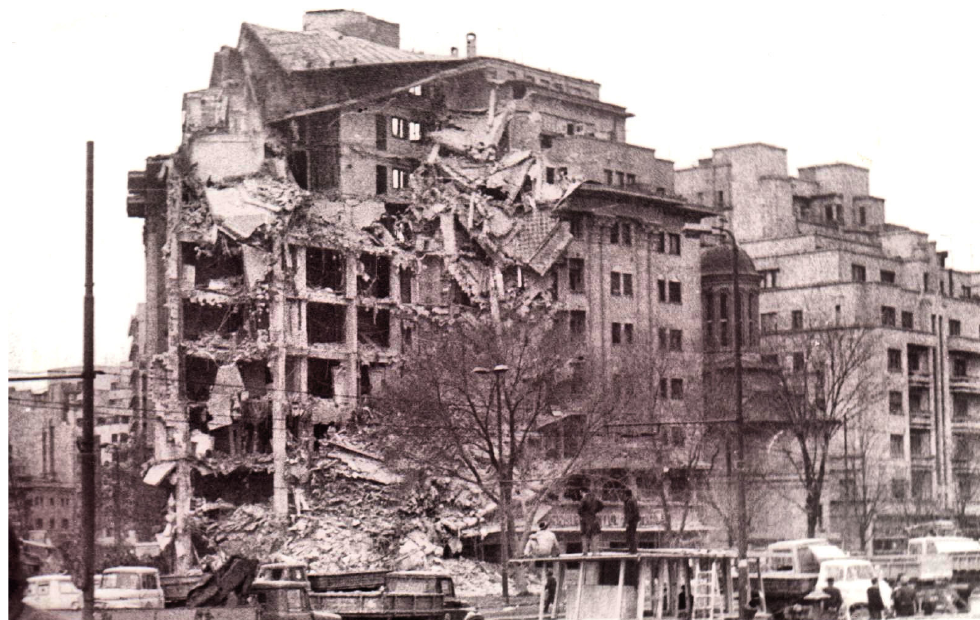
Figure 9. Partial collapse of the 'Dunarea' building (reinforced concrete frame building with masonry infill walls) (photo by Ene